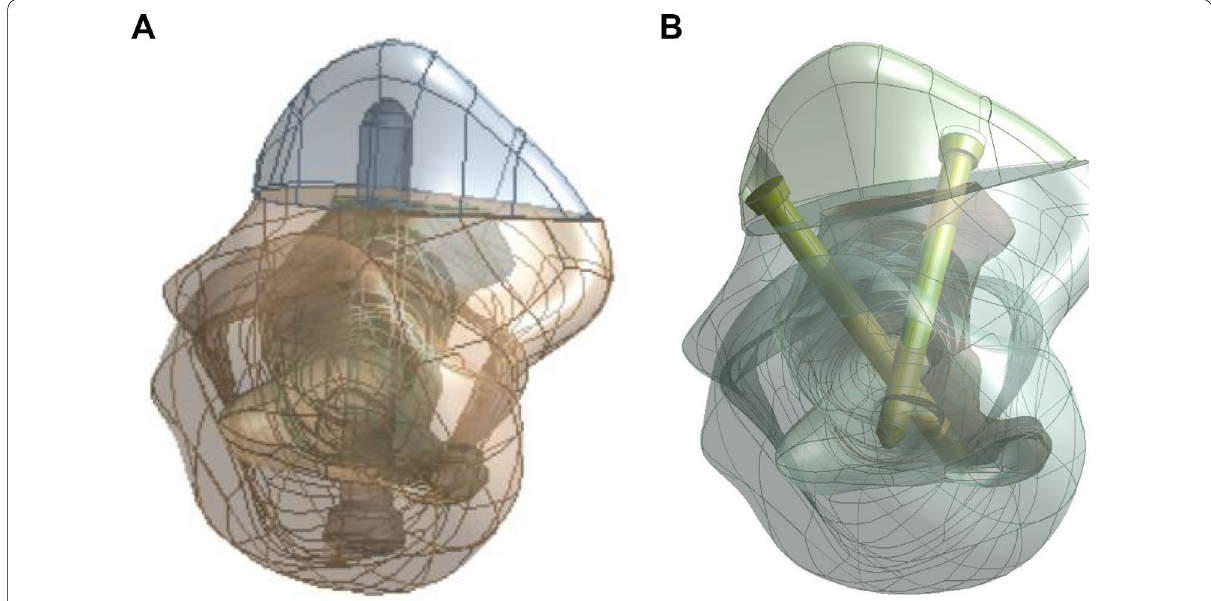
Fig. 2 Fixation of the coronoid prosthesis with a single or double bolt. A Fixation of the coronoid prosthesis with a single bolt; the direction of the bolt is perpendicular to the bone–prosthesis interface from posterior to anterior. B Fixation of the coronoid prosthesis with a double bolt; the direction of the screw is 60° to the bone–prosthesis interface in the coronal plane from anterior to